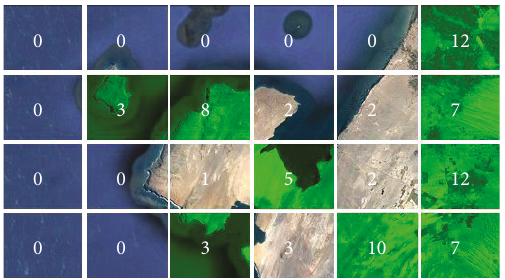
Figure 6: Repeatability for combined N